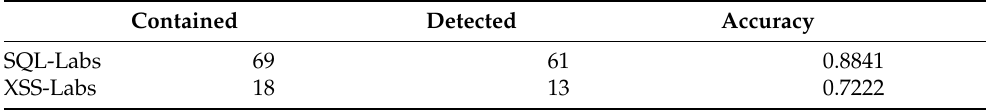
Table 11. generalization capability test